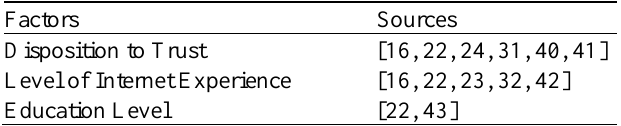
Individual Characteristics Influencing